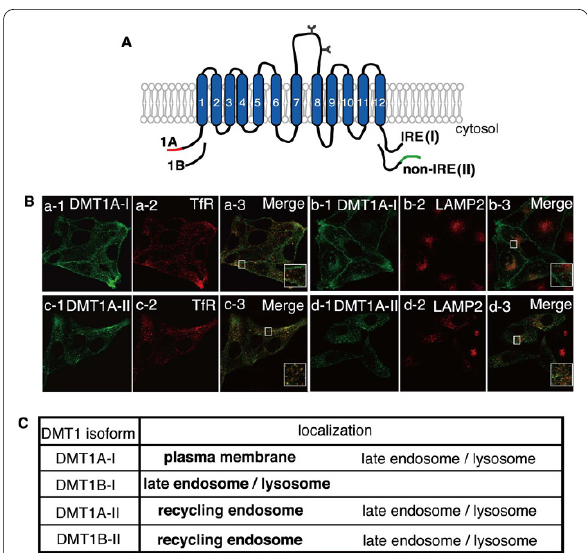
Figure 4 Subcellular localizations of 4 DMT1 isoforms . A. Four iso- forms of DMT1. B. GFP-tagged DMT1A-I (a and b) or GFP-tagged DMT1A-II (c and d) was transfected into HEp-2 cells. The cells were fixed and stained with antibodies against TfR (a-2 and c-2) and LAMP2 (b-2 and d-2). C. The localizations of the 4 DMT1 isoforms are indicated. Bold letters indicate the main localization of each isoform.